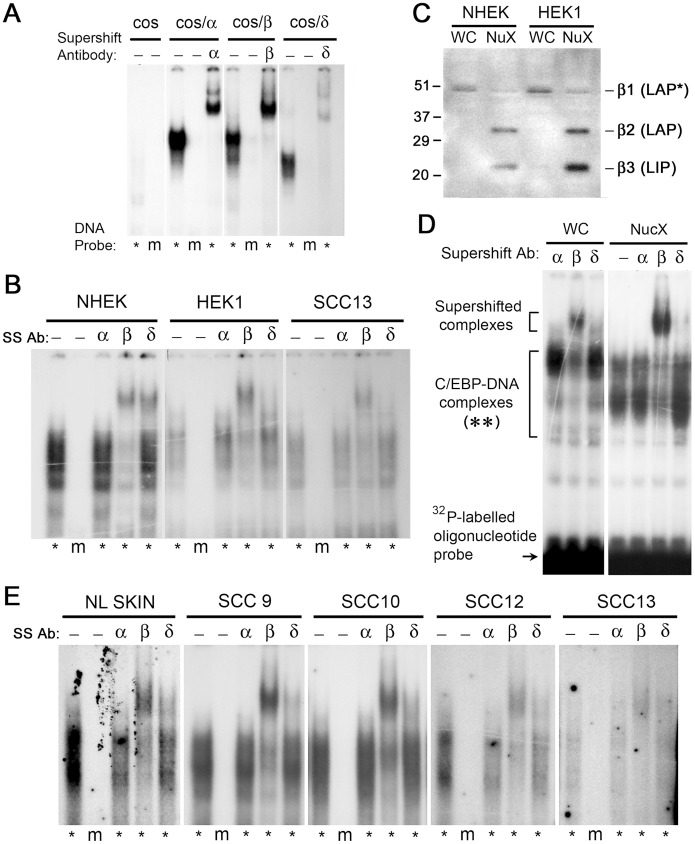
C/EBPβ, and to a lesser extent C/EBPδ, are the predominant C/EBP proteins that bind DNA in human SCC tumors.Protein lysates from cultured cells (A–D) or from tumors (E) analyzed by EMSA (panels A, B, D and E) or by western blot (panel C). Lysates were incubated with a 32P-labeled double-stranded DNA probe containing an authentic C/EBP consensus binding sequence (*), or a mutated sequence (m), and the protein-DNA complexes were run on an acrylamide gel and detected by autoradiography. In some lanes, a supershifting antibody to C/EBPα, C/EBPβ, or C/EBPδ, was added to the mixture prior to electrophoresis, as indicated. Lysates for the experiments were: (A) Nuclear extracts from cos-7 cells transfected with plasmids encoding full-length C/EBPα (cos/α), C/EBPβ (cos/β), or C/EBPδ (cos/δ); (B) Nuclear extracts from normal keratinocytes (NHEK) or from HEK1 or SCC13 cells; (C) Nuclear extracts (NucX) or whole-cell (WC) extracts from NHEK or HEK1; this panel is an analysis by western blot for C/EBPβ; (D) Nuclear extracts or whole-cell extracts from HEK1, analyzed by EMSA; (E) Whole-cell extracts of frozen tissue from SCC specimens previously analyzed in Fig. 3. The unbound 32P-probe is shown only in panel D.